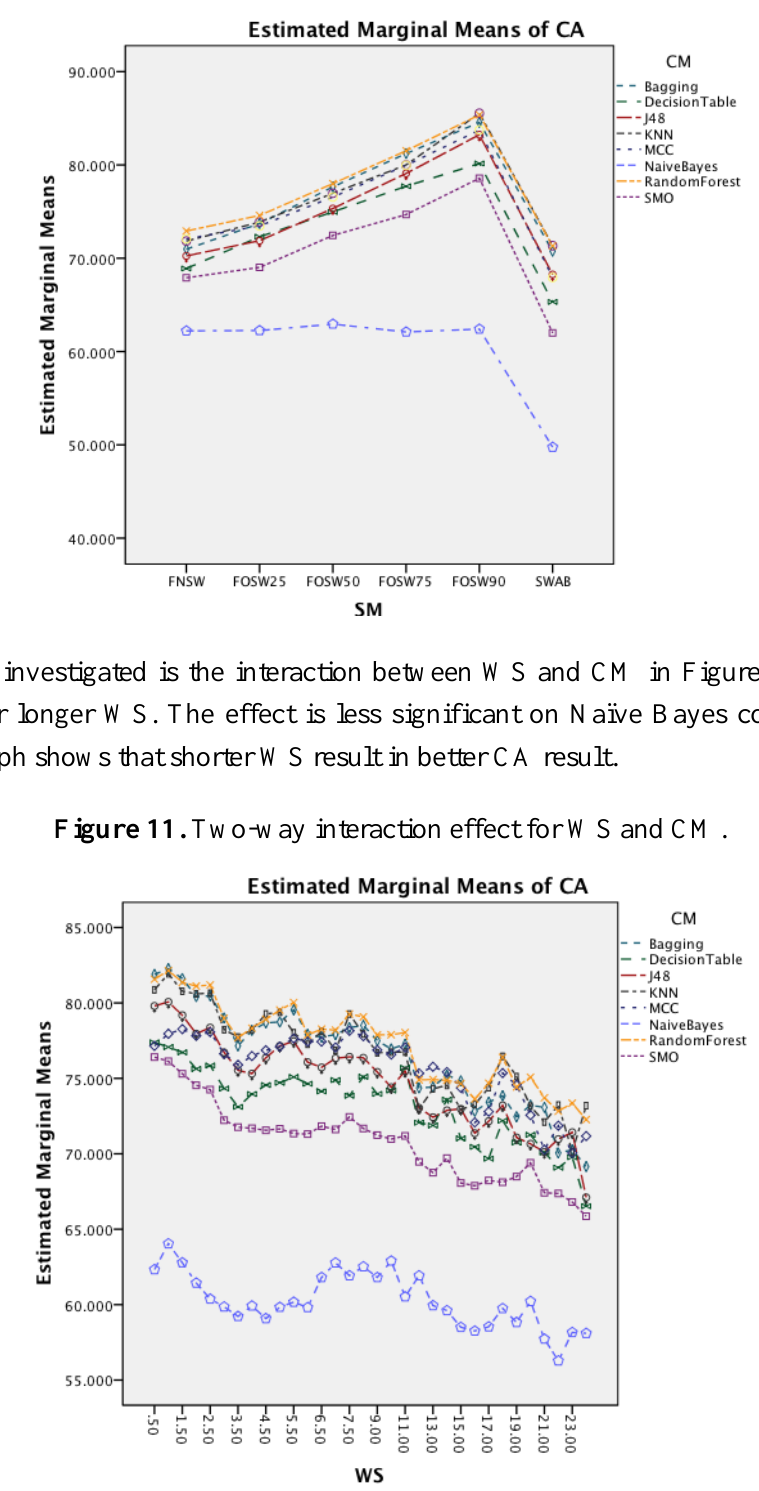
Figure 10. Two-way interaction effect for SM and CM.